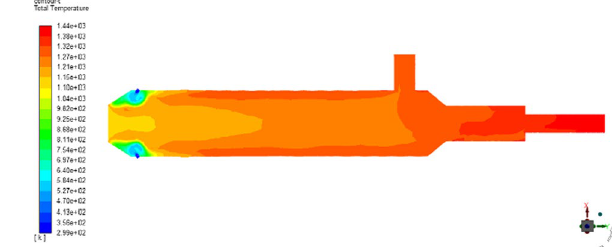
Fig. 8 Temperature distribution in the second combustion chamber